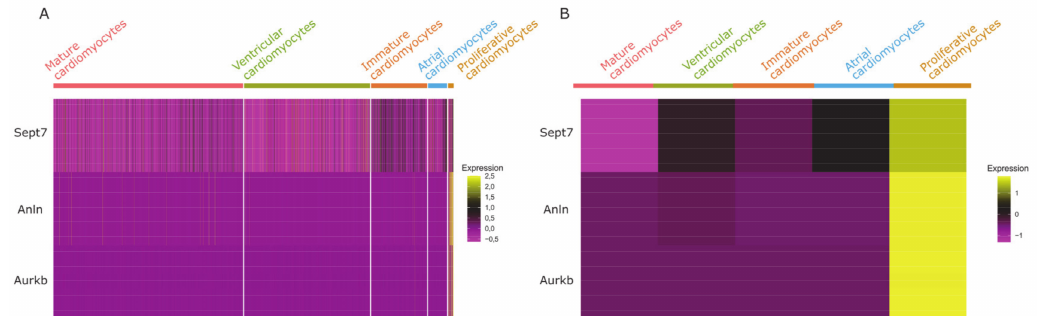
Figure 5. Heatmap of cytokinesis marker expression in cardiomyocyte clusters. ( A ) Expression levels of three factors involved in cleavage furrow assembly during cytokinesis are shown for each individual cell in the cardiomyocyte clusters. ( B ) Expression of cytokinesis markers averaged for each cardiomyocyte cluster shows the result more clearly, demonstrating the notable expression of cytokinesis markers exclusively in the “proliferative cardiomyocyte